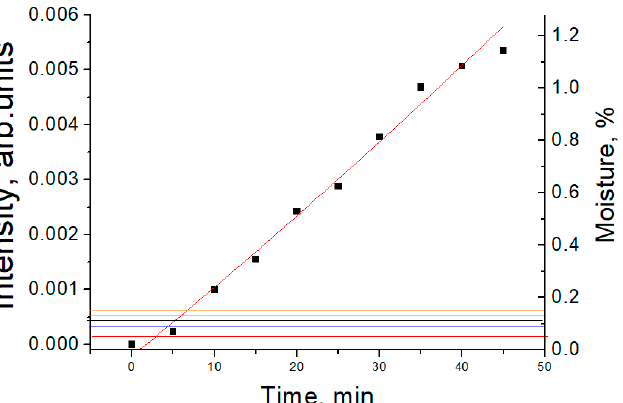
Figure 9. Correlation between the average integral intensity of the libration band of kaolinite sam- ples and moisture, depending on the time of adsorption of water vapor from the air. The right ver- tical axis shows the sample moistures calculated using libration band intensities.